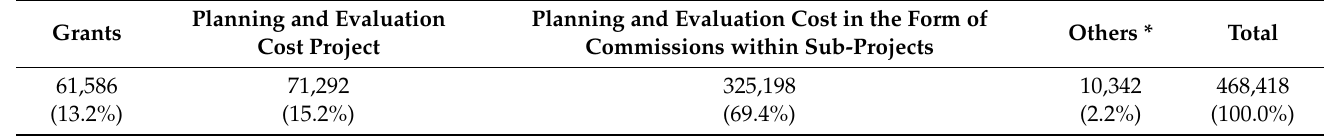
Table 6. Financial structure of planning and evaluation cost (2020). (Unit: KRW million,